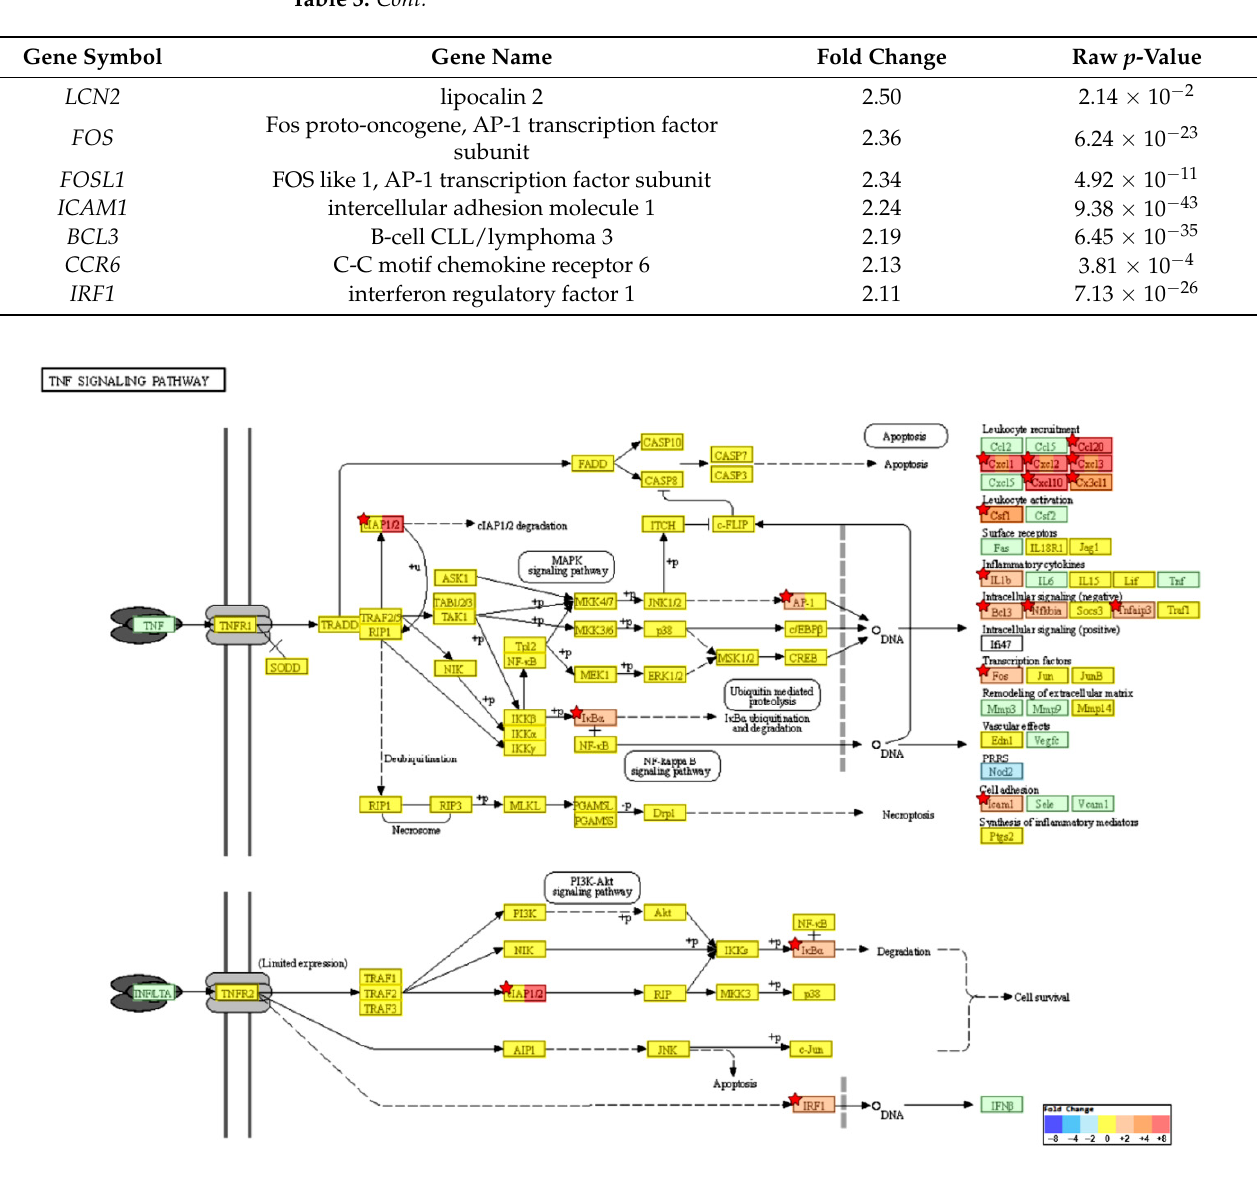
Figure 6. TNF signaling pathway (KEGG map, has04668) of differentially expressed genes from CotG-p75 stimulated Caco-2 cells. Fold change value is expressed based on the color key. Modules with significantly selected DEGs are marked with a red star symbol. Blue indicates modules to which down-regulated genes are mapped. Red indicates modules to which up-regulated genes are mapped. Green indicates modules made up of genes present in a species whose expression cannot be determined. Table 3. List of genes involved in immune response in Caco-2 cells stimulated with CotG-p75.